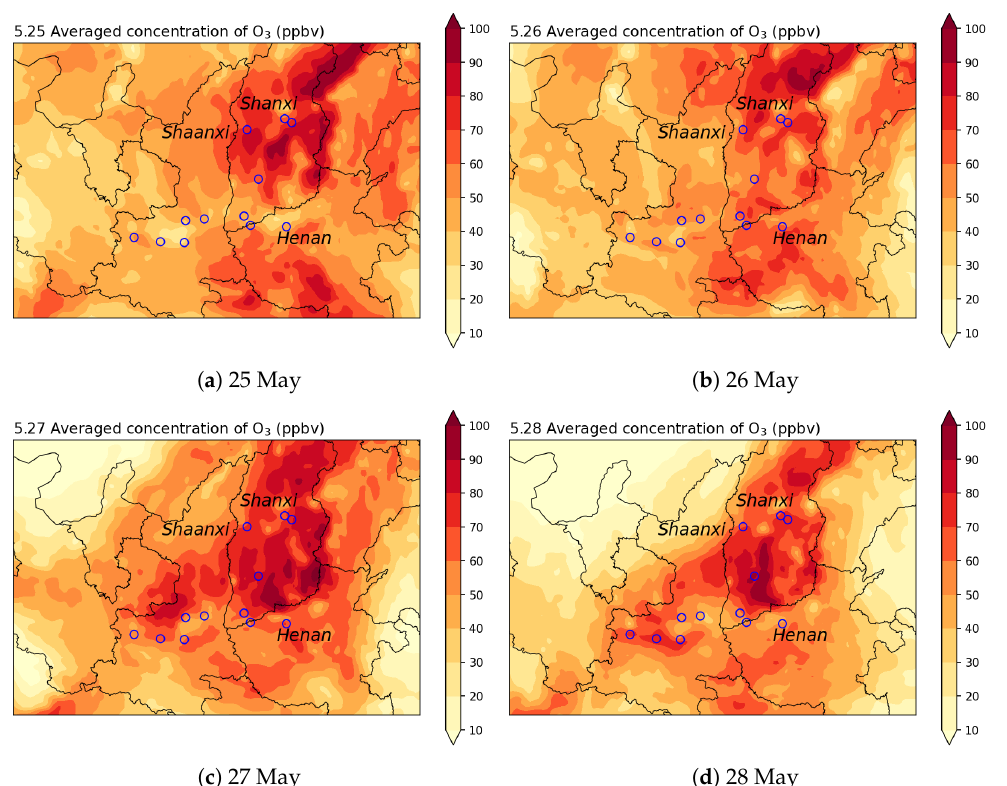
Figure 6. Spatial distributions of daily mean ozone on different days. Cities in Fenwei Plain are marked by blue